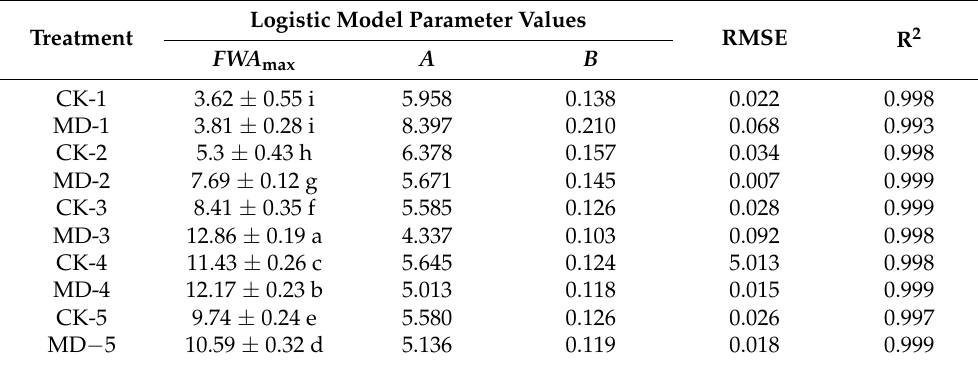
Table 2. Parameters of the logistic model for the fresh weight of aerial part of different treatments. Treatment